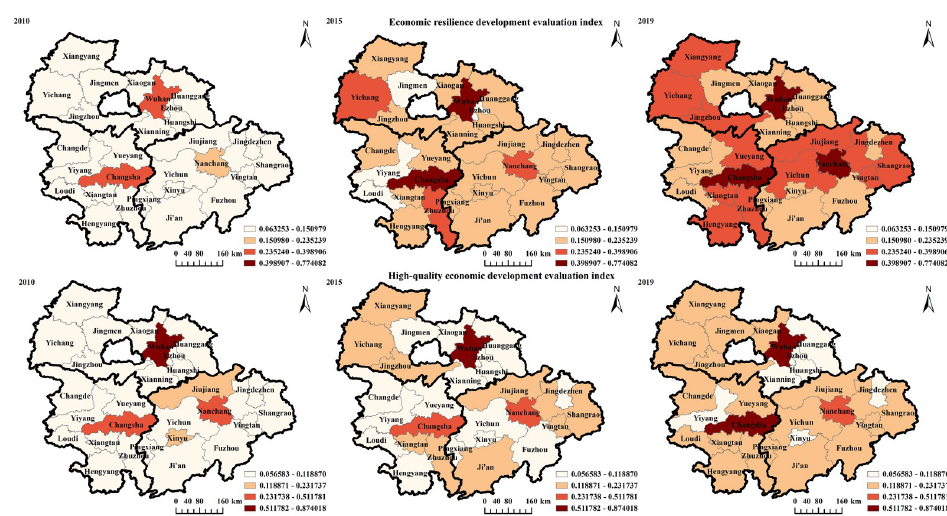
Fig 1. Spatio-temporal evolution of economic resilience and high-quality economic development in the UAMRYR. The image was created using ArcGIS 10.2 software with the authors’ data.